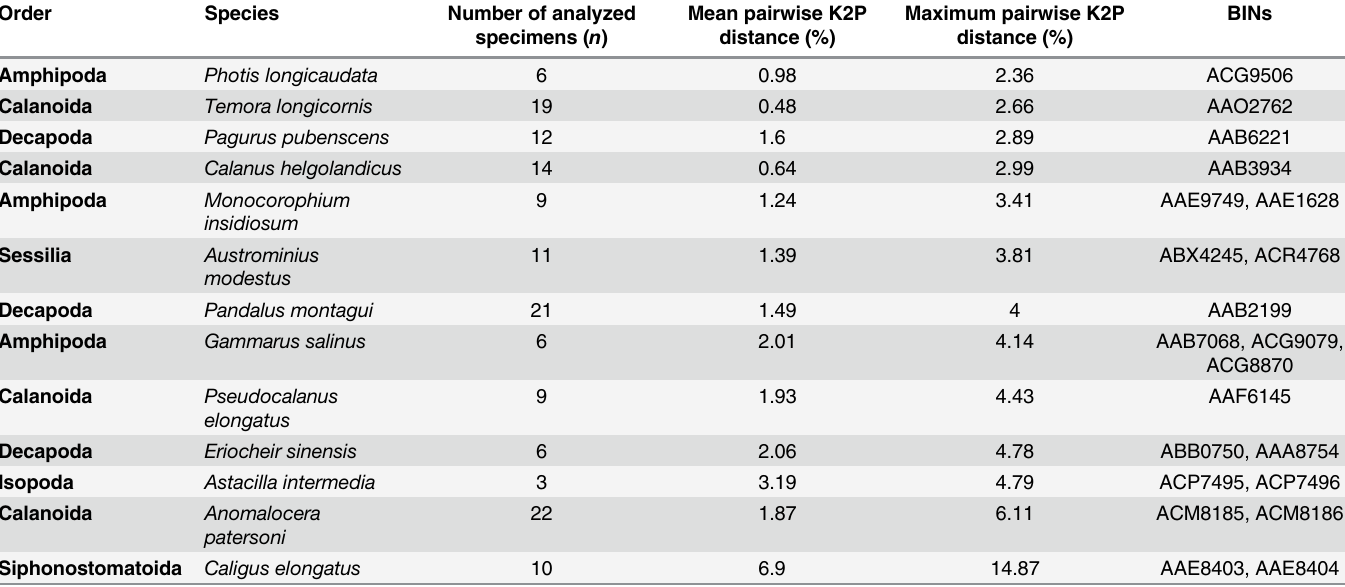
Table 2. Table of 13 species of the Crustacea with a maximum intraspecific distance (K2P) of > 2.2%. At least two specimens of the listed species showed a distance value higher than the threshold as part of a pairwise comparison.